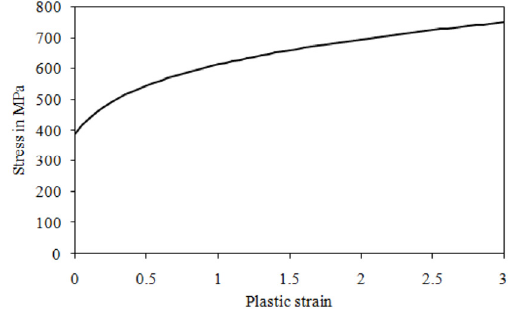
Figure 7. The hardening curve for 16MnCr5 used in the FE simulation of the cold extrusion process [30]